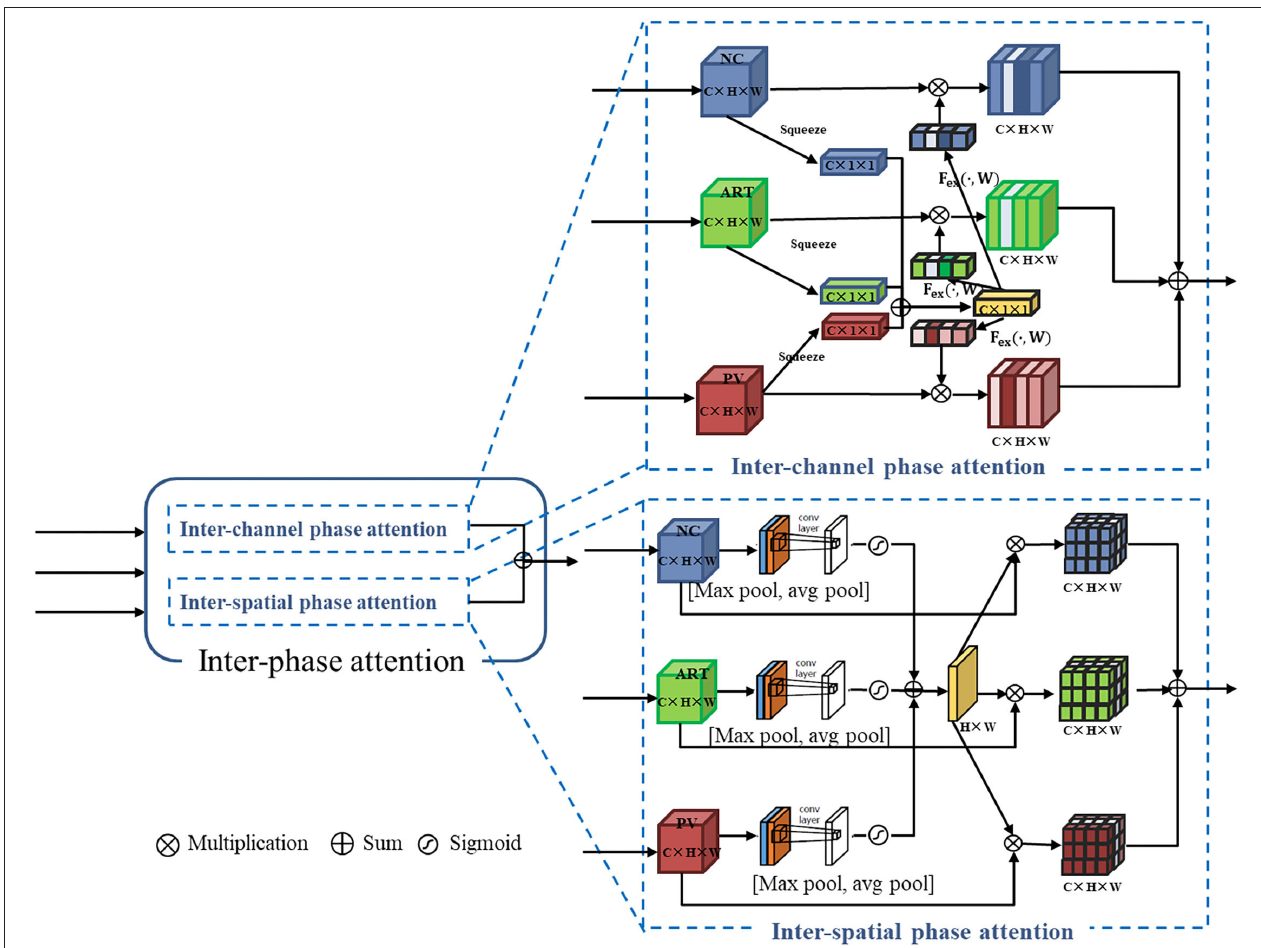
FIGURE 5 | Inter-phase attention structure containing inter-channel phase attention and inter-spatial phase attention: they are in parallel.